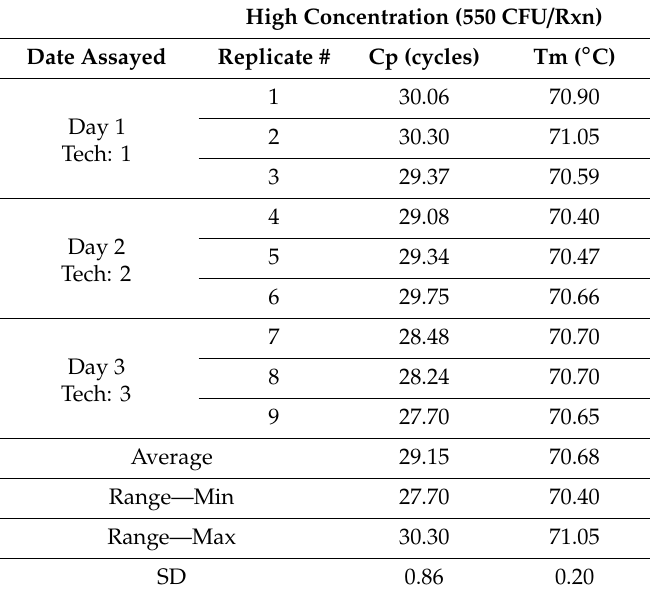
Table A3. Inter-day precision: 3 replicates tested at 3 concentrations (high, medium, low) over 3 days, with testing performed by 3